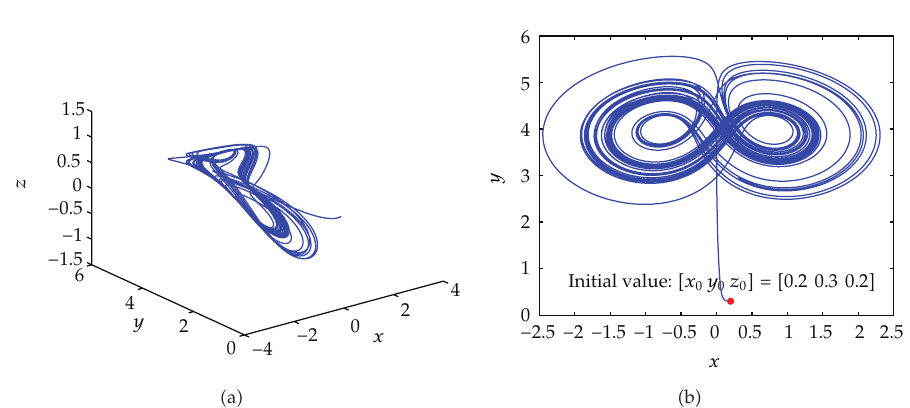
Figure 4: The numerical solutions of Example 4.2 with incommensurate fractional order derivatives and step size h (cid:7) 0 . 02 (cid:3)(cid:3) a (cid:4) 3D portrait; (cid:3) b (cid:4) x - y projection (cid:4) .